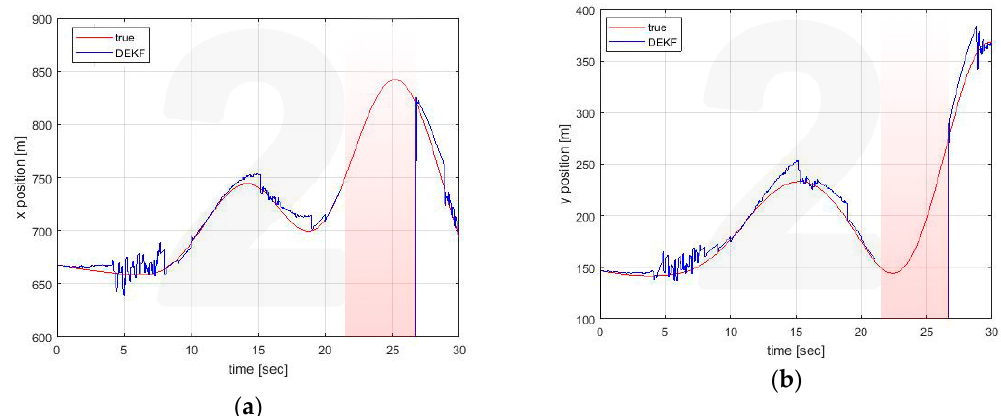
Sensors 2020 , 20 , x FOR PEER REVIEW Figure 6. ( a ) Position estimation performed by Vehicle 1 on Vehicle 2 position ( a ) x axis ( b ) y axis. Figure 6. ( a ) Position estimation performed by Vehicle 1 on Vehicle 2 position ( a ) x axis ( b ) y axis. Figure 6. ( a ) Position estimation performed by Vehicle 1 on Vehicle 2 position ( a ) x axis ( b ) y axis.